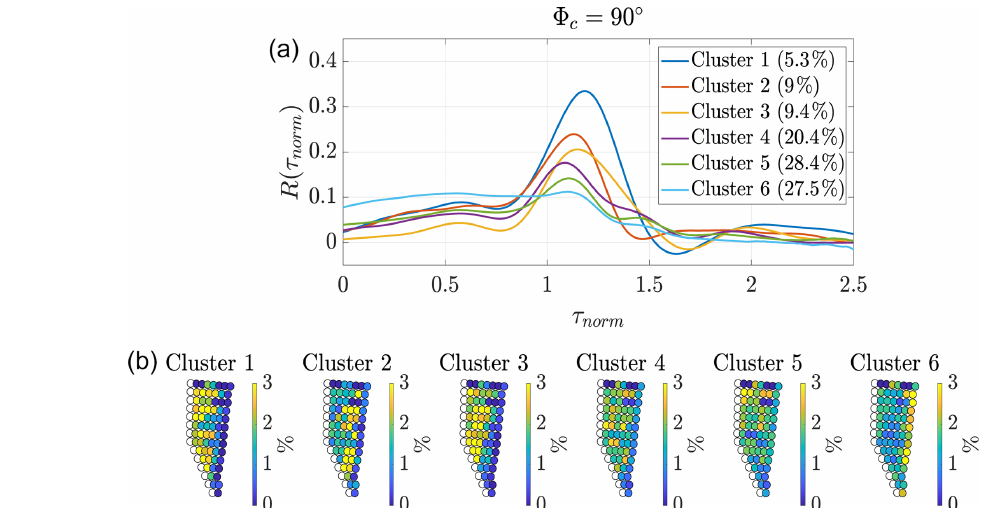
Figure C1. Clustering for wind direction interval around 90 ◦ with randomly sorted parameters and k = 6. (cid:56) c depicts the centre of the wind direction interval.